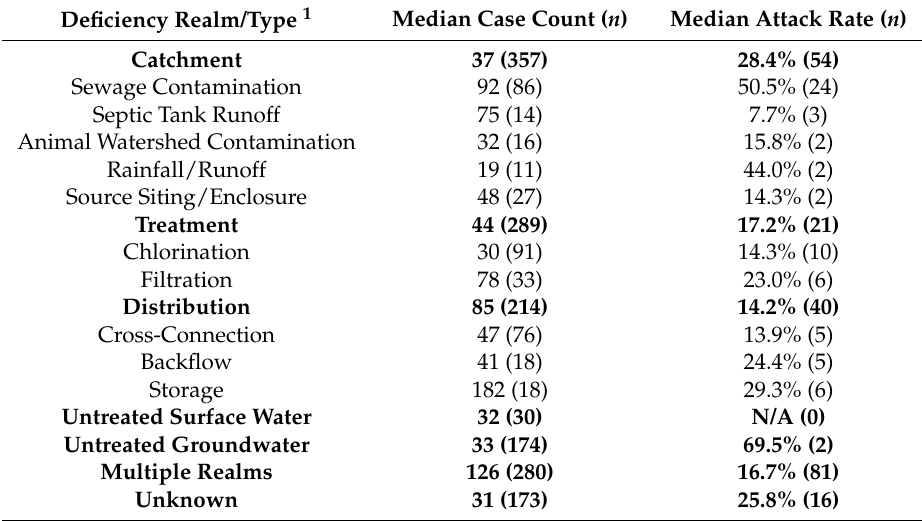
Table 9. Outbreak health data by deficiency realm (in bold) and type.